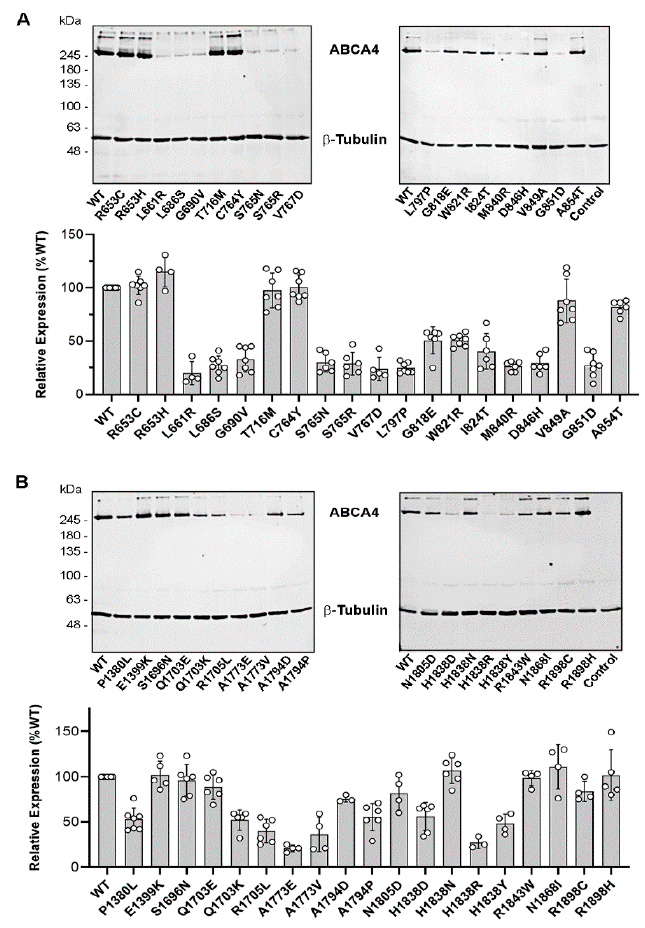
Figure 2. Solubilization of ABCA4 TMD variants. HEK293T cells expressing ABCA4 variants were solubilized in CHAPS. After the removal of aggregated material by centrifugation, the cell supernatants were resolved by SDS gel electrophoresis and analyzed on Western blots labeled for ABCA4 and β -tubulin as a loading control. ( A ) (Upper) Representative Western blots of TMD1 variants. (Lower) Quantification of TMD1 variants relative to WT ABCA4. ( B ) (Upper) Representative Western blots of TMD2 variants. (Lower) Quantification of TMD2 variants relative to WT ABCA4. The control sample represents non-transfected HEK293T cells. Quantified profiles are the mean of relative expression levels ± SD for n ≥ 4, where each point represents an independent